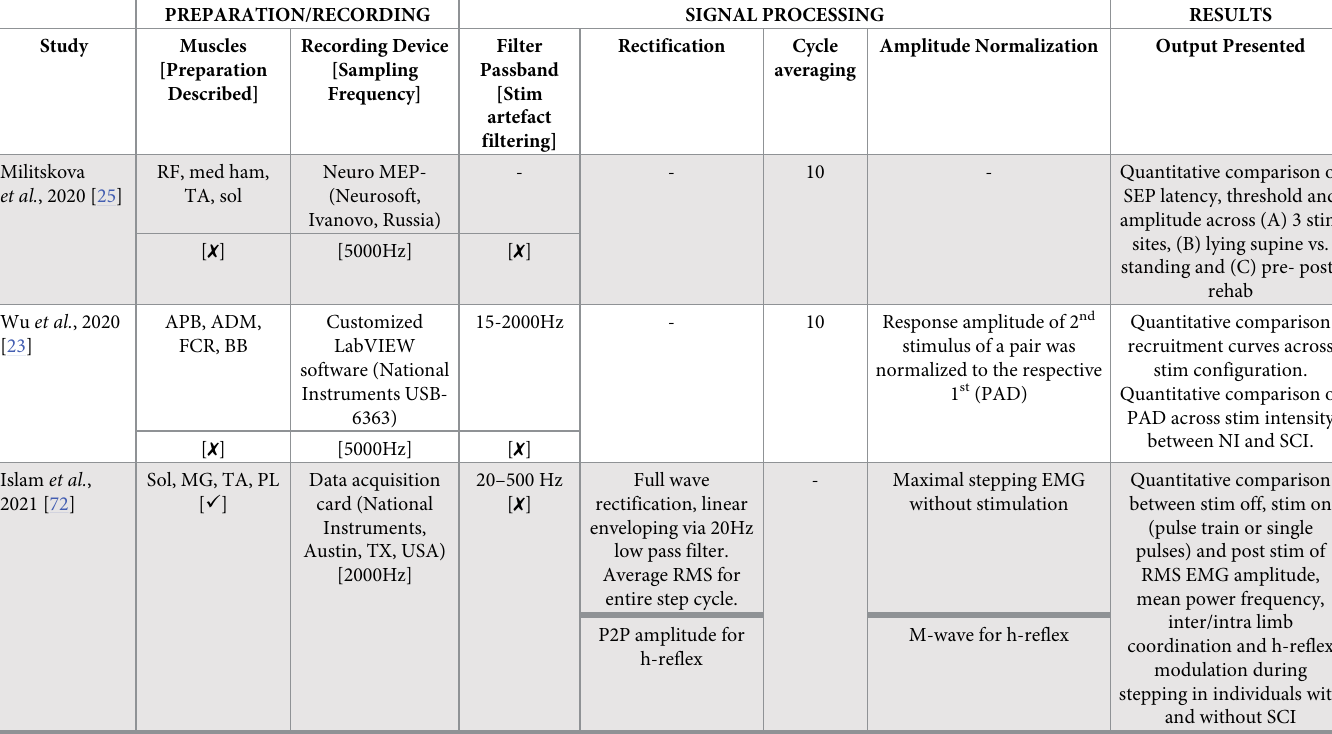
Quantitative comparison of SEP latency, threshold and